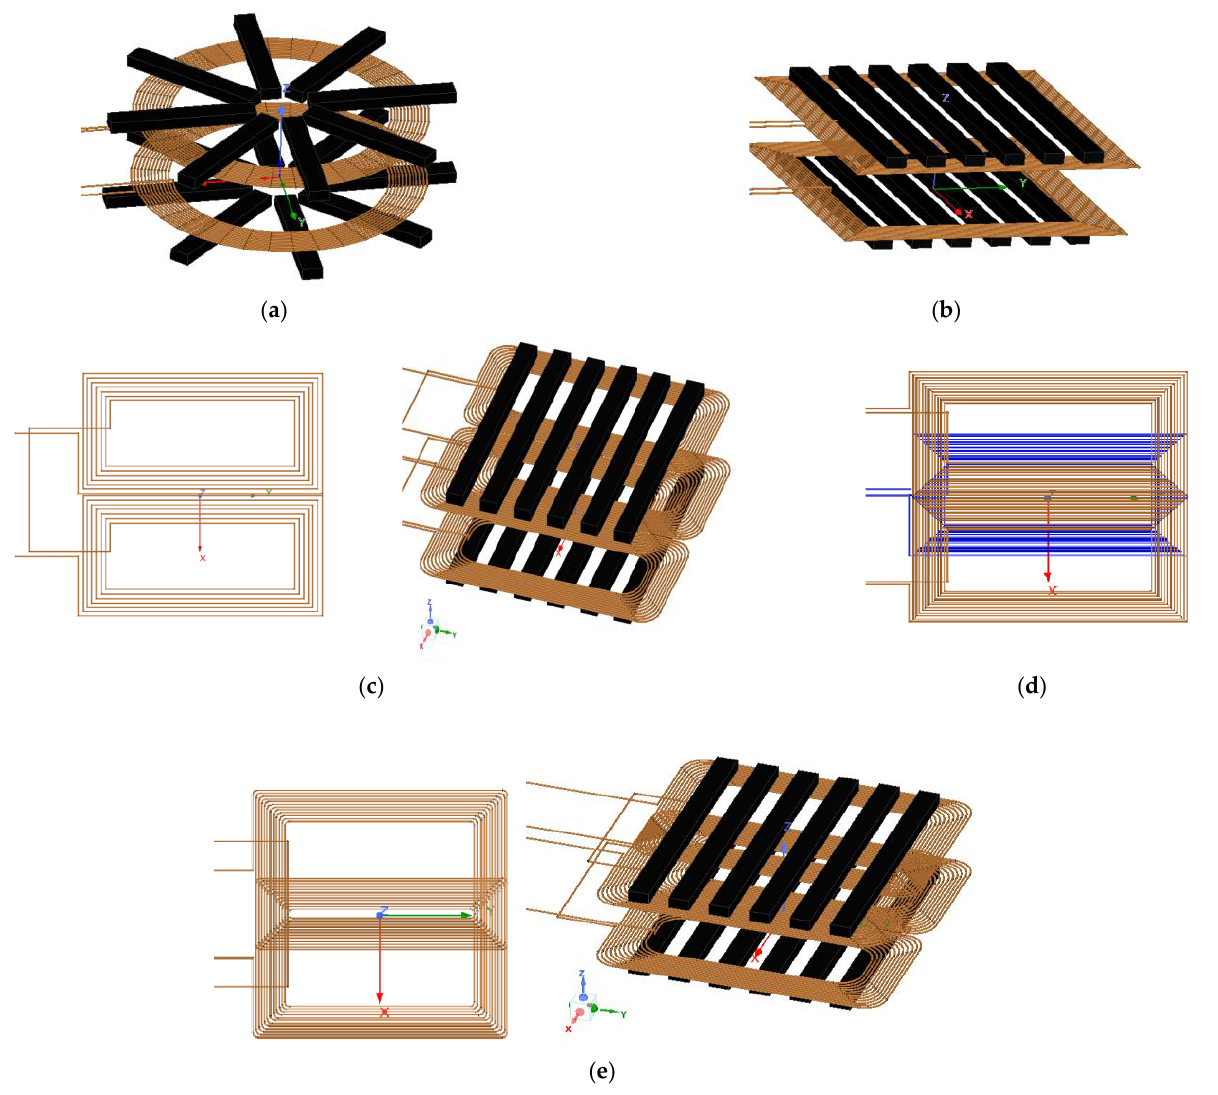
Figure 5. Different pads structures for static IPT systems. ( a ) Circular pad. ( b ) Rectangular pad. ( c ) DD pad. ( d ) DDQ pad. ( e ) BP pad.